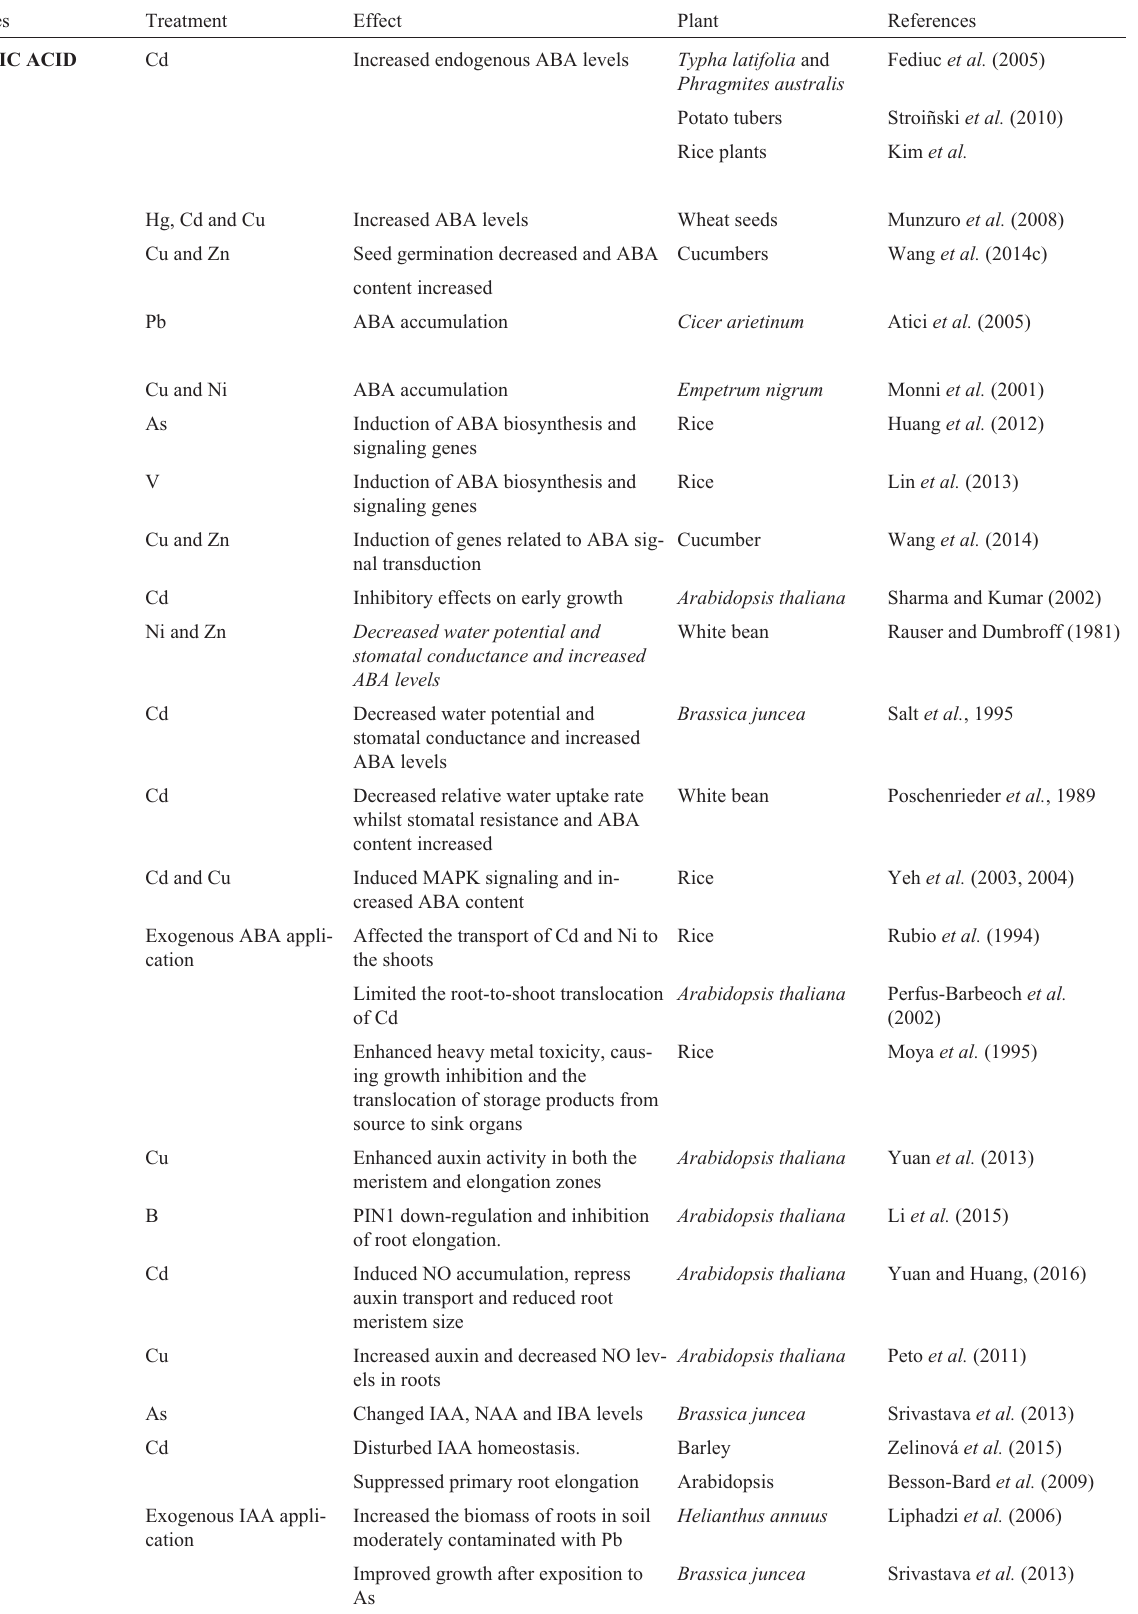
Table 1 - Interrelation between phytohormone and heavy metal